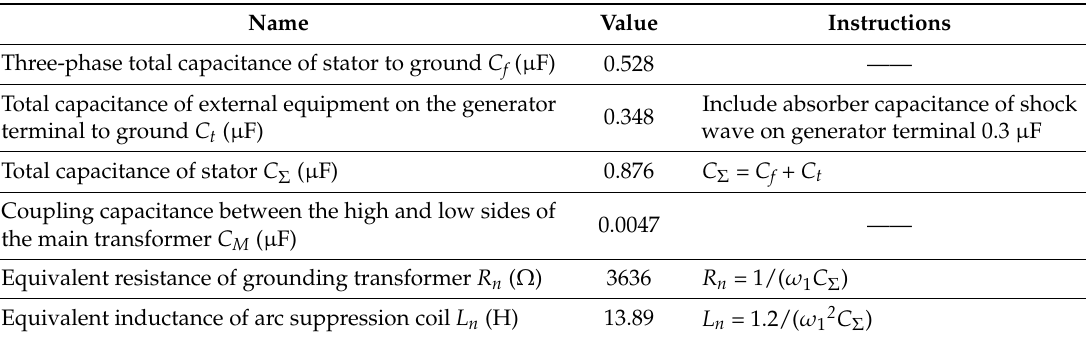
Table 1. Parameters of a 300 MW generator.